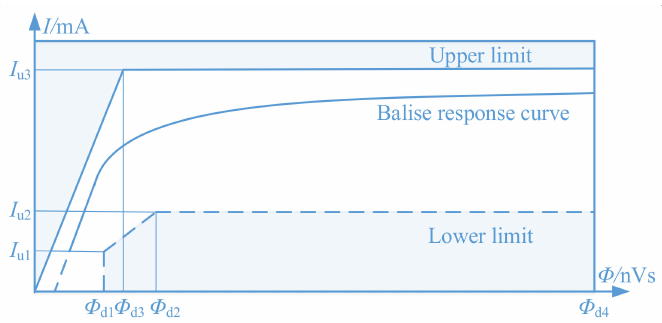
Figure 6. Balise input–output